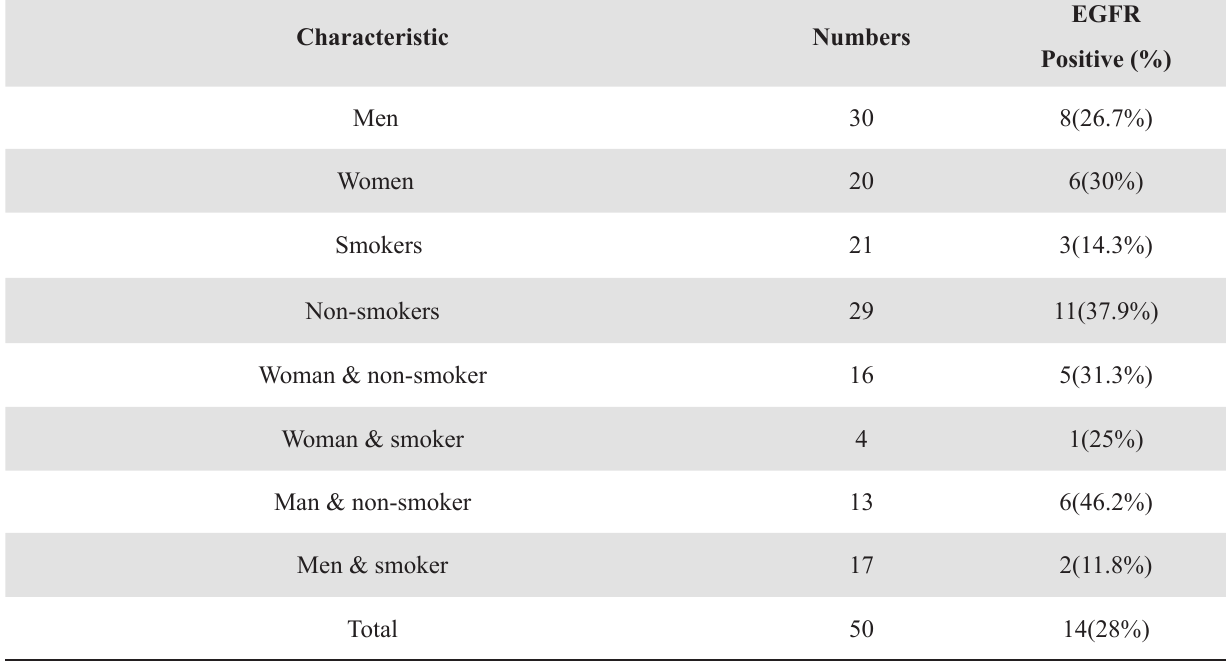
Table 2 . Percentage of mutation in different cases according to clinical